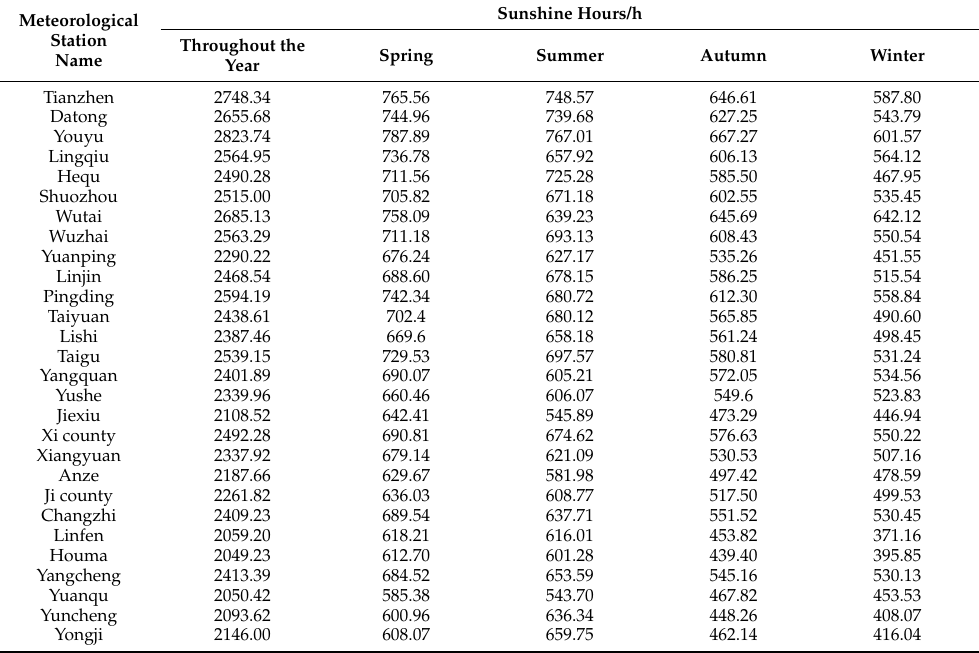
Table 2. Annual average sunshine hours of each meteorological station in Shanxi